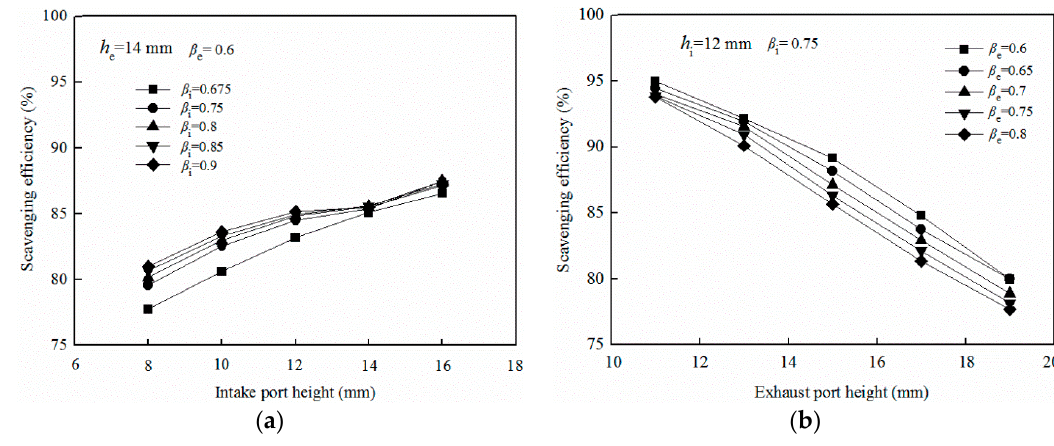
Figure 11. Effect of the port height and circumference ratio on scavenging efficiency ( a ) Intake port; ( b ) Exhaust